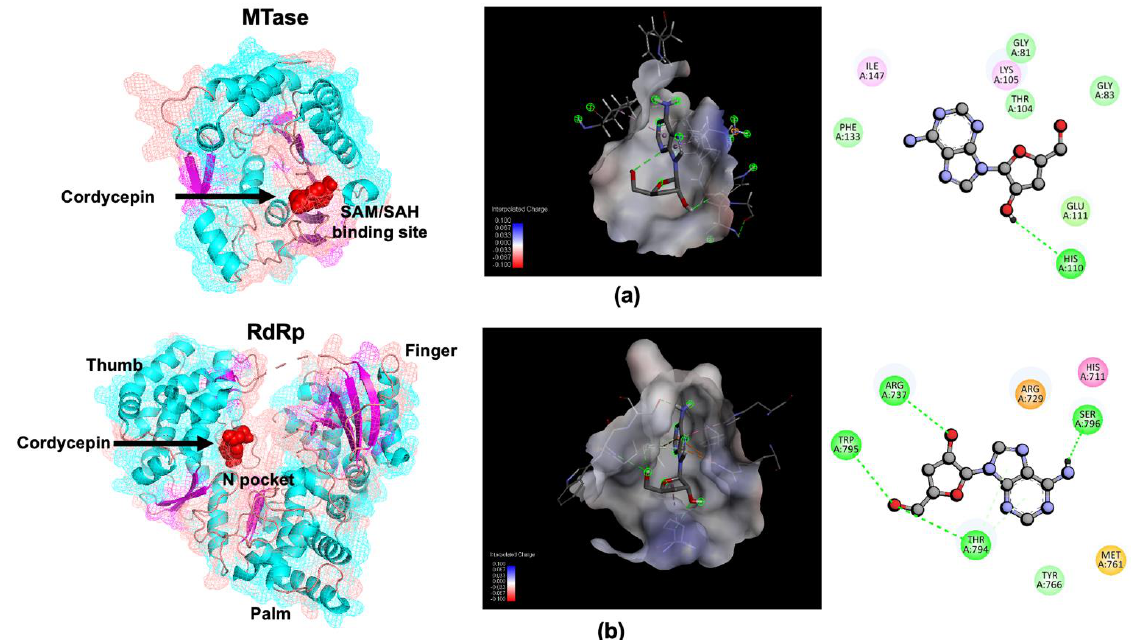
Figure 4. Molecular docking demonstrating cordycepin interaction with dengue NS5 protein. ( a ) The interaction of cordycepin with SAM/SAH binding site in the MTase domain was predicted (left and middle). Intermolecular interaction of cordycepin with the amino acid residues in the SAM/SAH binding site was shown in ball and stick (right) ( b ) The interaction of cordycepin with N pocket of DENV2 NS5 RNA-dependent RNA polymerase (RdRp) was predicted (left and middle). Intermolecular interaction of cordycepin with the amino acid residues in the N pocket was shown in ball and stick (right).